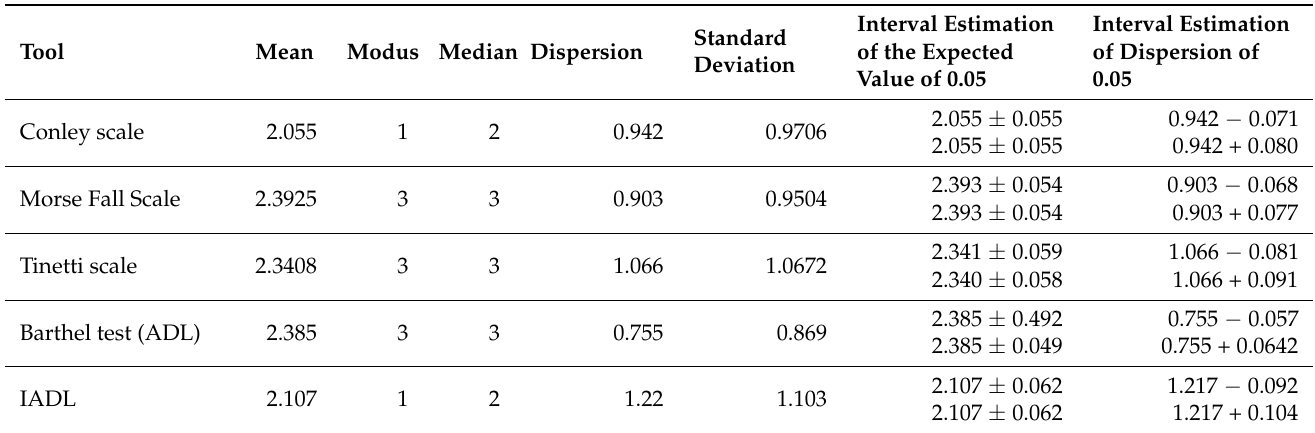
Table 5. Introduction of tools into respondents’ facility.